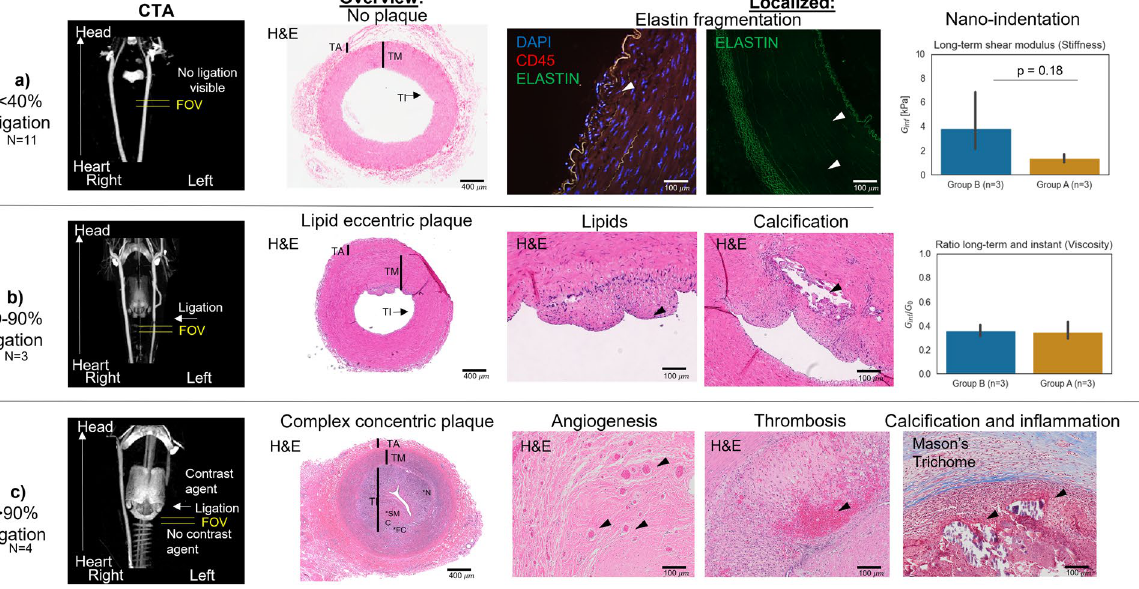
Figure 7. Qualitative example of histology. Significant plaque development can be observed in the >90% group, whereas plaque with less advanced features can be observed in the 40–90% group. While no plaque features were observed in group A, elastin fragmentation was observed as indicated by an interruption of the elastin fiber. Nanoindentation results showed a non-significant ( p =0.18) increased long-term relaxation shear modulus G inf indicating that group B appears to have more stiff components than group A. No difference in viscosity was observed between the two groups. Abbreviations: H & E: hematoxylin and eosin. CTA: computed